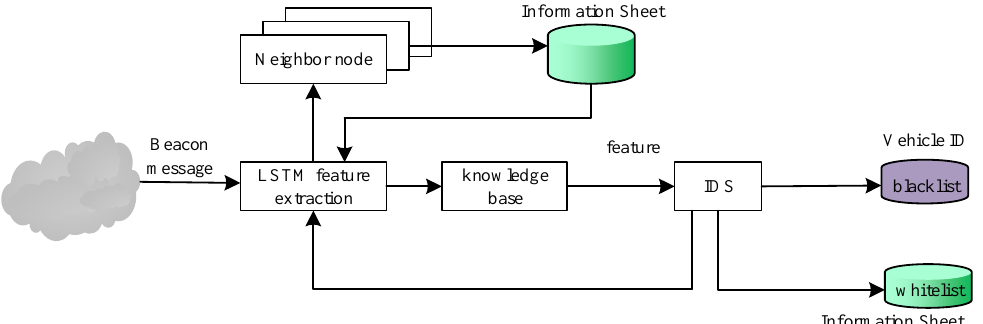
Figure 7. Self-learning-based intrusion detection model.